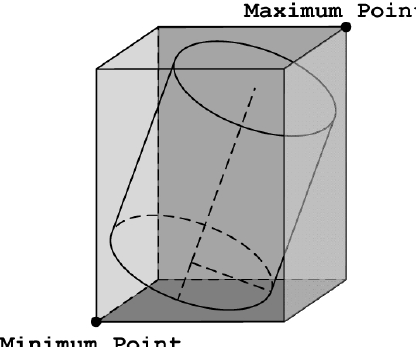
Figure 5 : Example of AABB generation for 3D cylinder. Figure 4. Network of asset workflows. Figure 4 : Network of asset workflows.